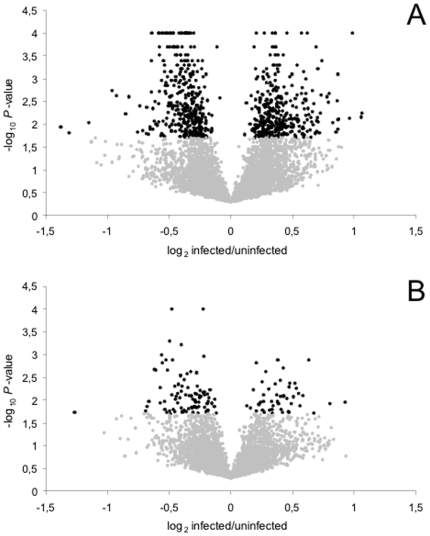
Volcano plots of the (A) male and (B) female experiments.The X-axis defines the magnitude of expression difference between the infected and uninfected state, the Y-axis the corresponding P-value of the BAGEL analysis. Probes for which BAGEL assigned a P-value of 0 (i.e., P<0.0001), were set to P = 0.0001. Black dots represent probes up-regulated (log2 infected/uninfected>0) or down-regulated (log2 infected/uninfected<0) in the infected state at P<0.02.